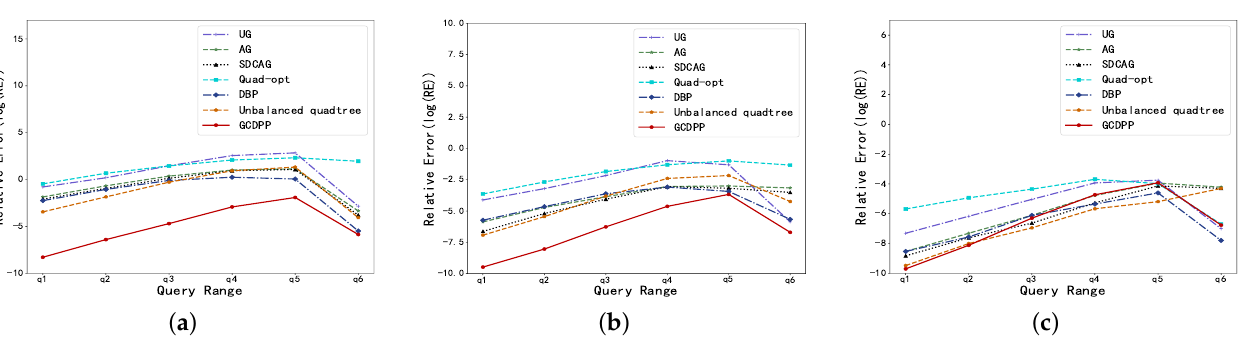
Figure 13. Comparison of querying accuracy on Checkin dataset. ( a ) Checkin dataset, (cid:101) = 0.01; ( b ) Checkin dataset, (cid:101) = 0.1; ( c ) Checkin dataset, (cid:101) =